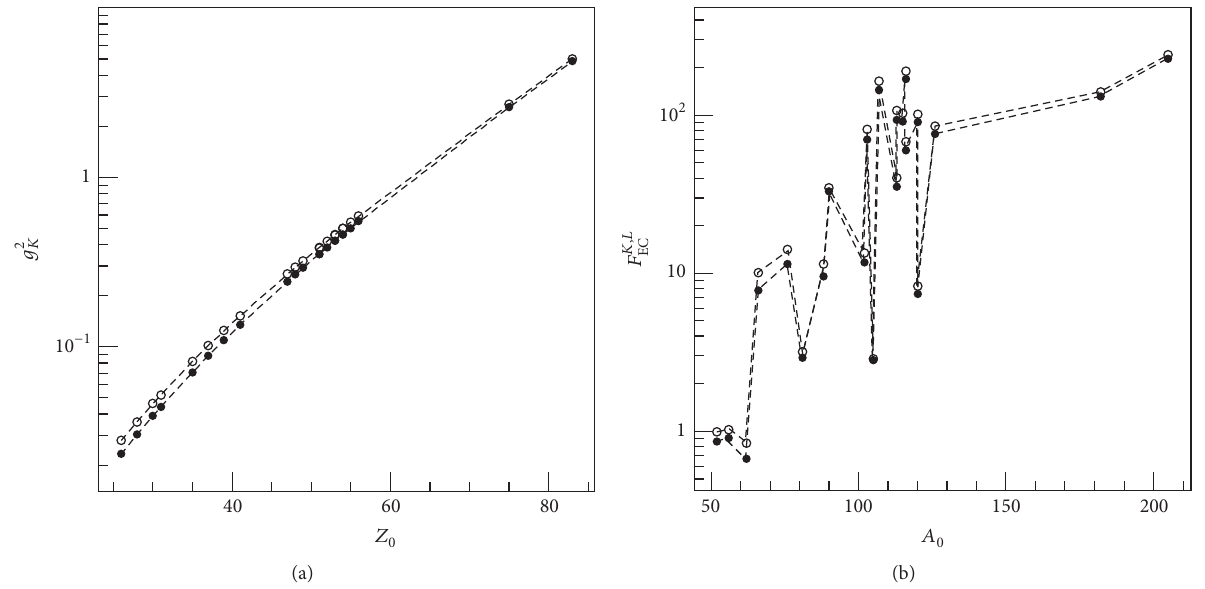
Figure 1: (a) Electron density on the nuclear surface of 1𝑠 1/2 state as a function of the atomic number of the parent nucleus. The values calculated with screening are displayed with filled circles and those without screening are plotted with empty symbols. The dashed lines are given to guide the eye. (b) Calculated PSF for EC as a function of the mass number of the parent nucleus. The filled circles display the calculation with screening, while the empty ones the calculation without